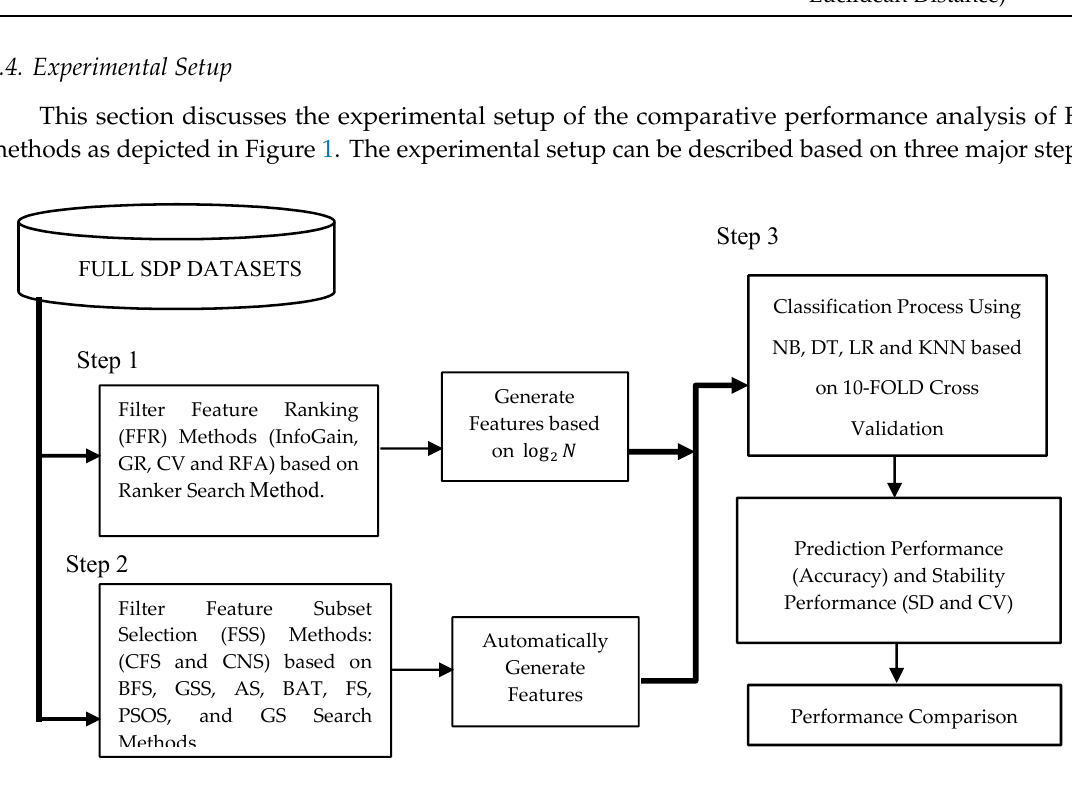
Figure 1. Experimental Setup.